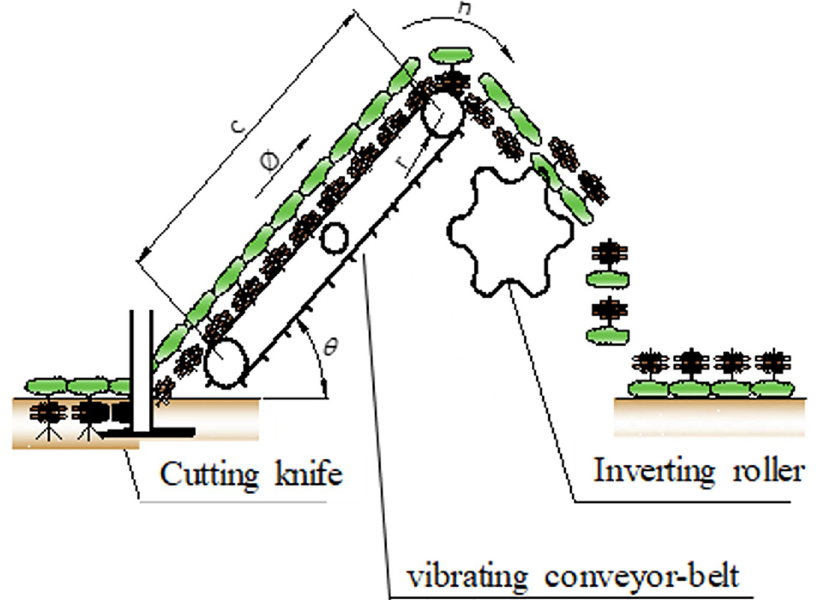
(leaving roots up and leaves down).